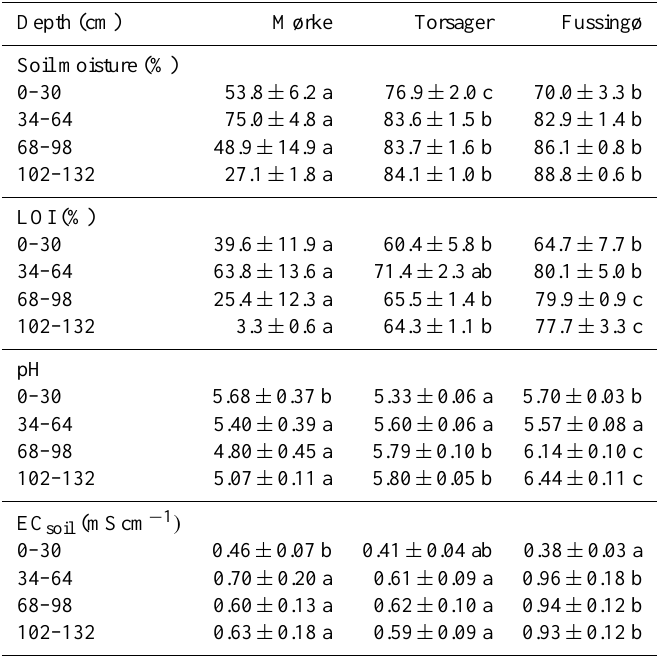
Letters indicate significant ( P <0.05) difference within